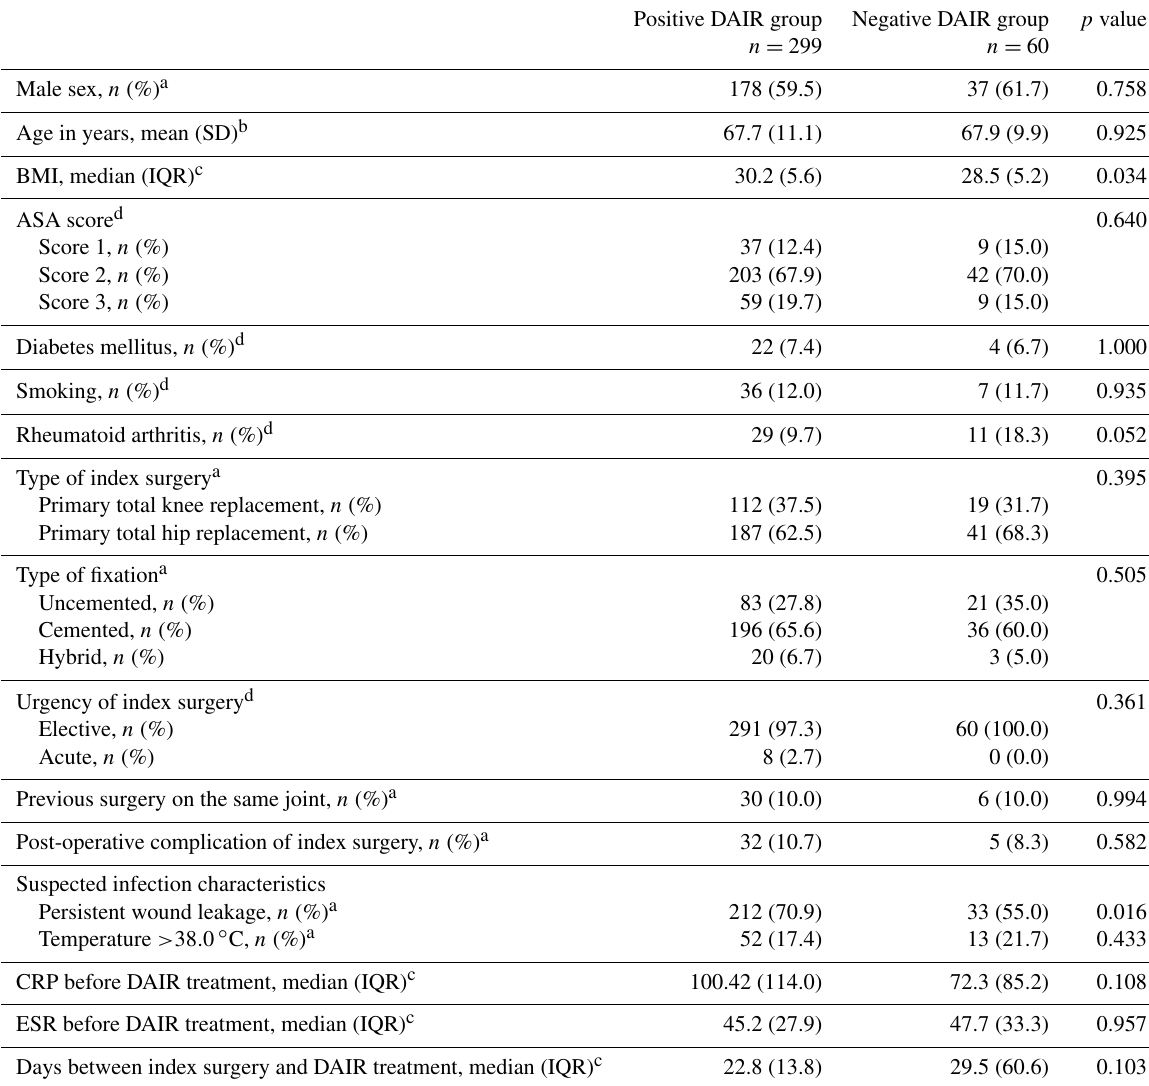
Table 1. Patient characteristics of DAIR-treated patients ( n = 359).